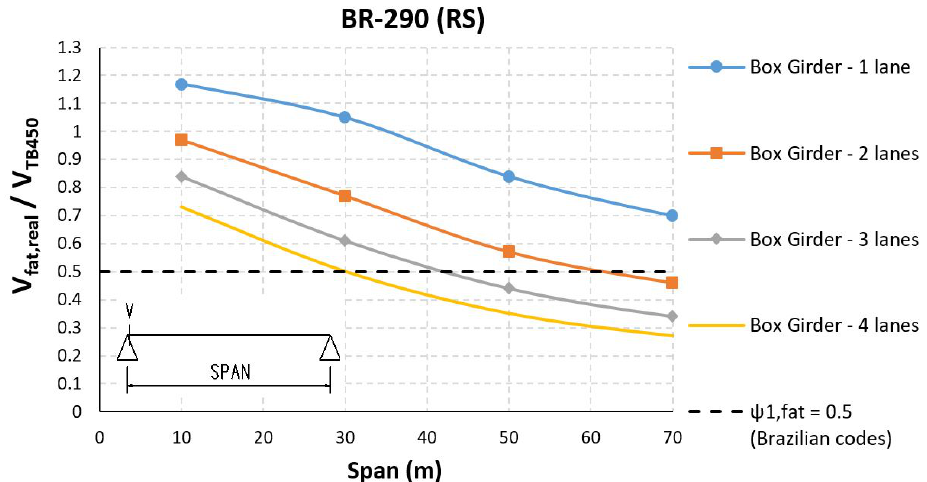
Figure 17. Bias factors for shear force at support in simply supported box-girder bridges – BR-290 (RS).